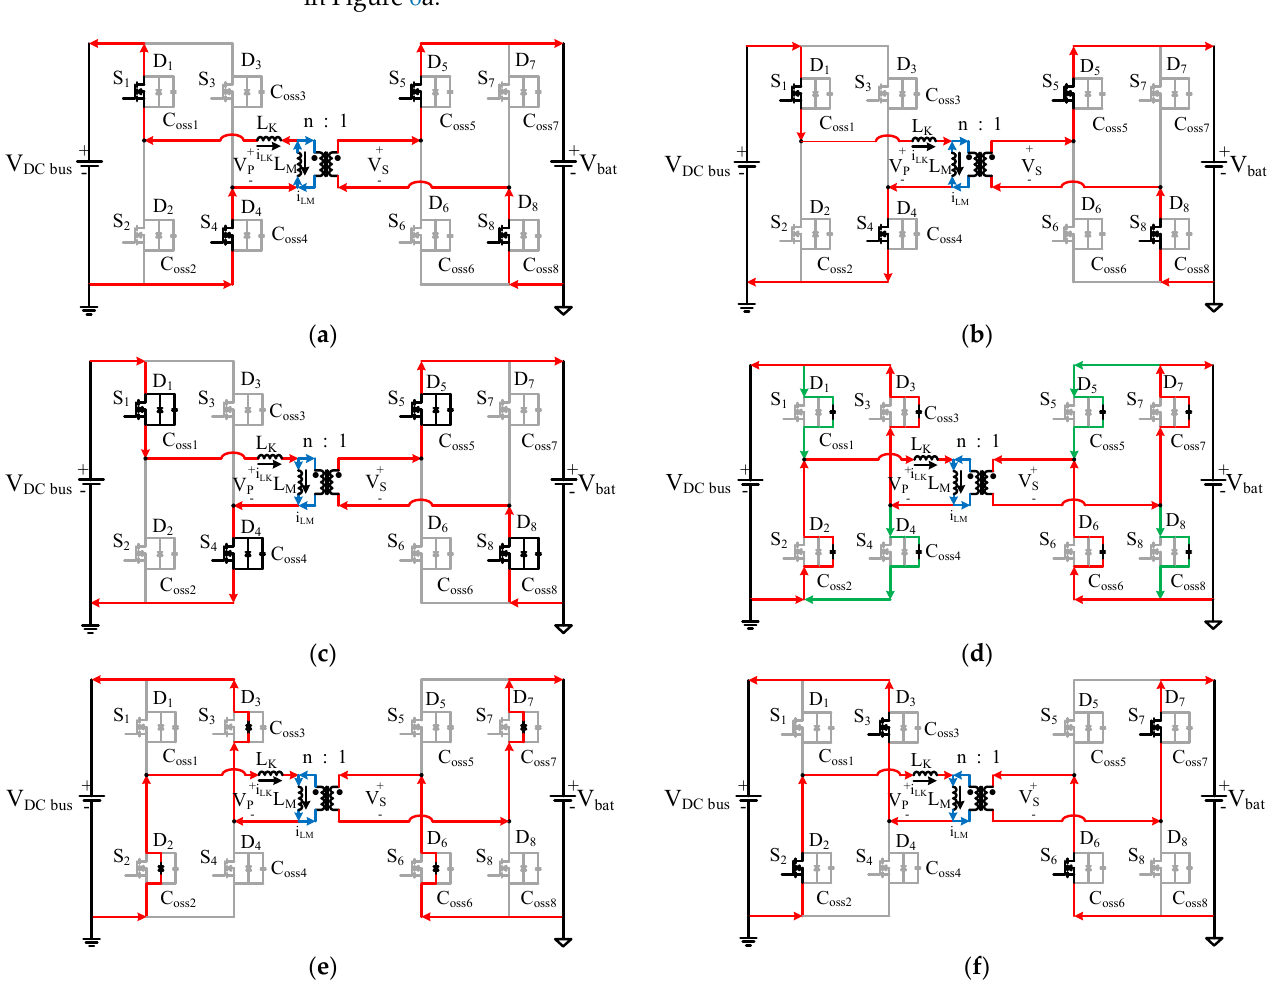
Figure 6. ( a – f ) The current flow path of the DAB converter in PWM control